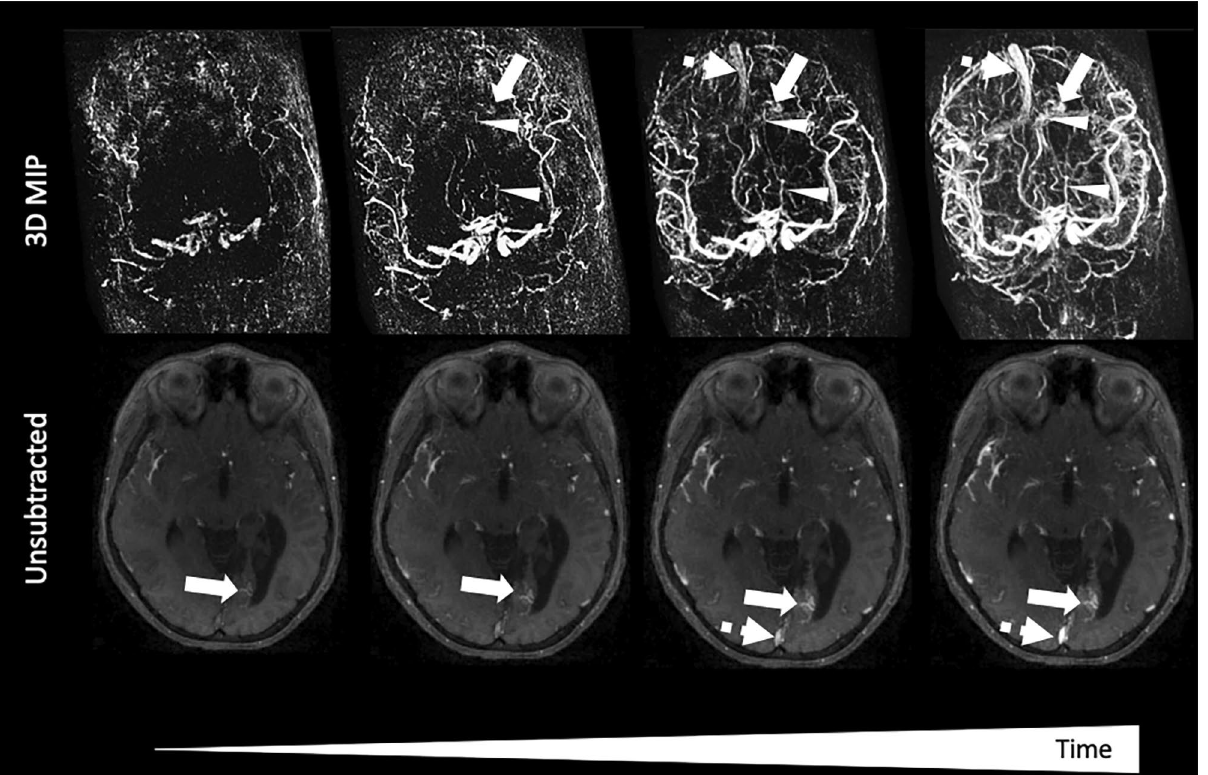
Figure 4. 45-year-old man with history of parenchymal hemorrhage. Paired 3D maximum-intensity projection (MIP) and axial unsubtracted GRASP images demonstrate a small vascular nidus (arrow) supplied by the left posterior cerebral artery (arrowheads) and early filling of the superior sagittal sinus (dashed arrow) due to arteriovenous shunting.